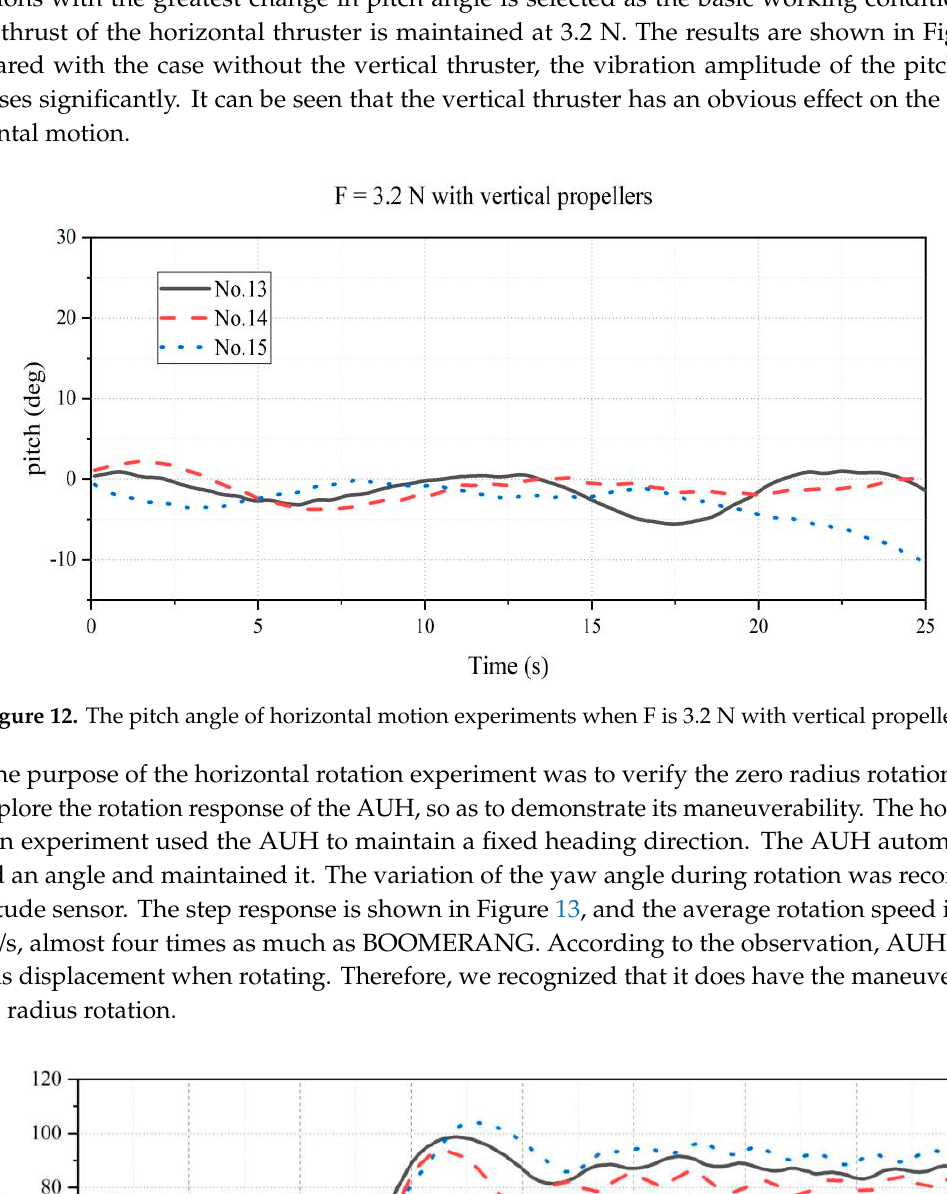
Figure 11. The pitch angle of horizontal motion experiments when F is ( a ) 0.7 N; ( b ) 1.3 N; ( c ) 2.2 N; ( d ) 3.2 N.